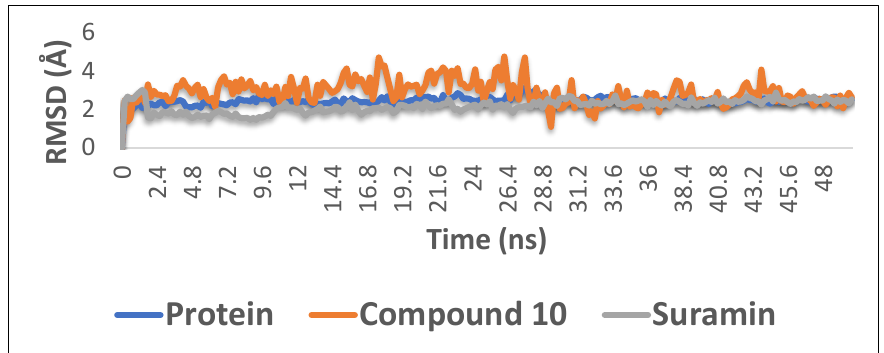
Figure 6. The RMSD curve from the molecular dynamics simulations of compound 10 . The x-axis represents the simulation time (in ps), while the y-axis represents the RMSD value (in nm).